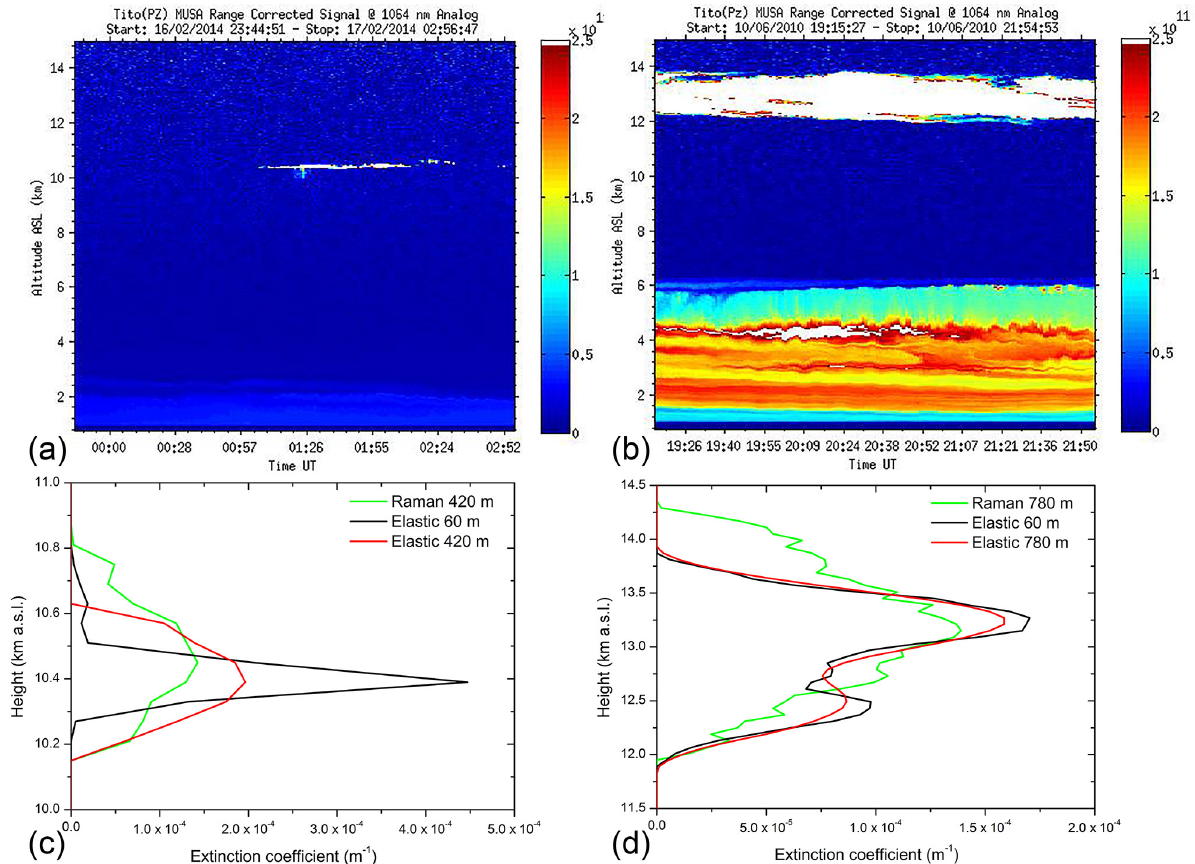
Figure 2. (a) Composite plot of the range-corrected signal at 1064nm showing a thin cirrus cloud at about 10km (b) and an opaque cirrus cloud centered at about 13km. (b) Lidar extinction profiles at 355nm from the Raman and elastic channel of the cirrus cloud on 17 February 2014 (signal temporally integrated from 01:29 to 02:13UT). The iterative method at the two different resolutions (60 and 420m) used a fixed S value (26sr), determined by climatological measurement. (d) Same as (c) but for a cirrus cloud detected on 10 June 2016 (signal temporally integrated from 19:42 to 20:44UT). The Raman lidar channel is smoothed over a 420 and 780m spatial window. On 10 June 2016, the elastic channel was retrieved using the MPLNET algorithm (Lewis et al., 2016) with S = 24sr at 60 and 780m